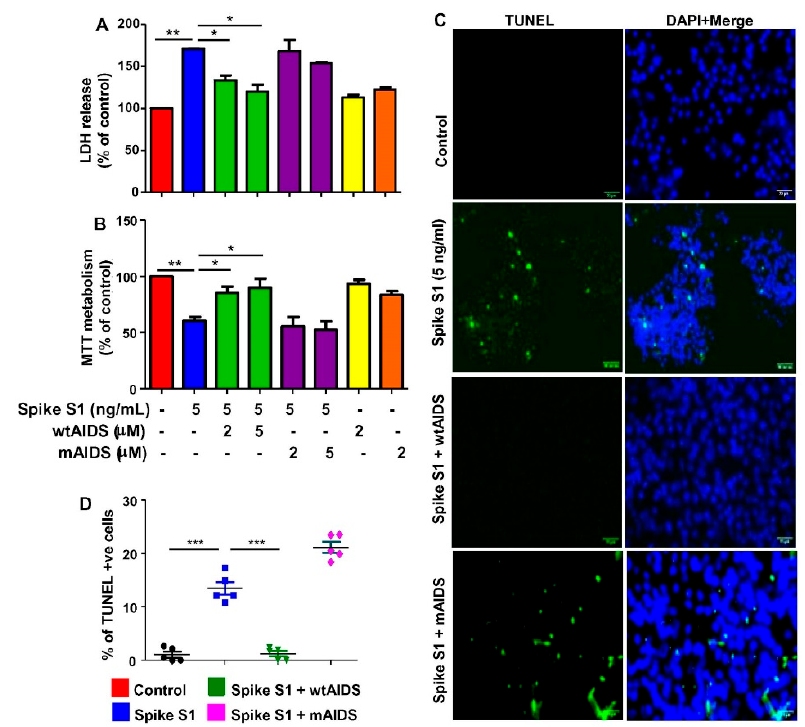
Figure 5. Selective disruption of ACE2-to-spike S1 interaction reduces spike S1-induced death in human A549 lung cancer cells. A549 cells were treated with 5 ng/mL spike S1 protein in the presence or absence of different concentrations of wtAIDS and mAIDS peptides under serum-free condition. After 24 h, cell viability was monitored by LDH release ( A ) and MTT ( B ). After 12 h of treatment, apoptosis was monitored by TUNEL ( C ). TUNEL positive cells were counted in 10 varied images per group and plotted as percent of total cells ( D ). Results are mean ± SD of three different experiments. * p < 0.05; ** p < 0.01; *** p < 0.001. Scale bar = 22 µm.